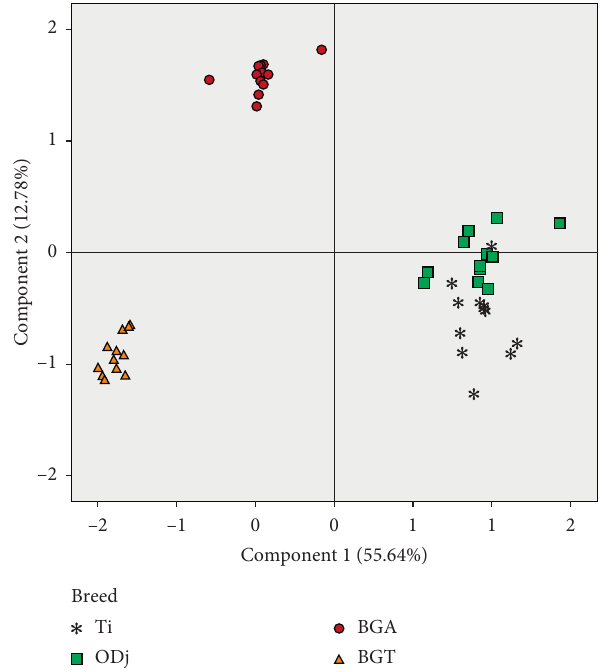
Figure 2: Projection of the variables of the four female lamb groups studied in the plane defined by two principal